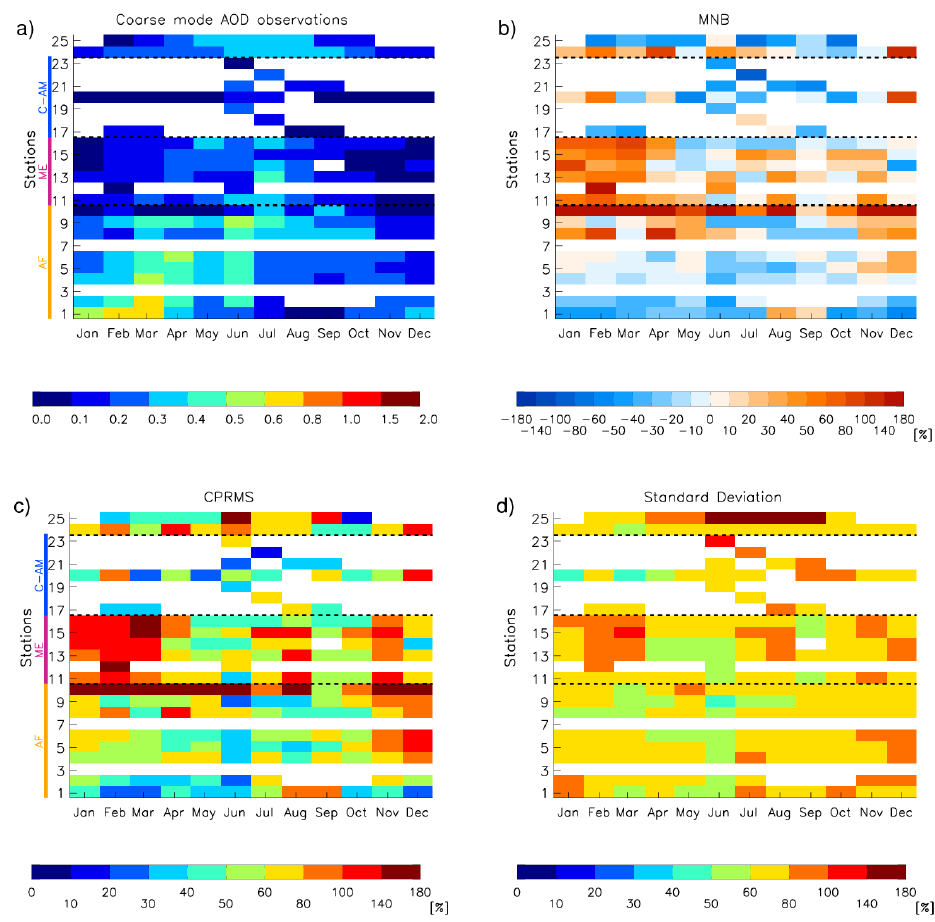
Fig. 11. Same as Fig. 10 but for coarse mode AOD. Same stations as the ones used for total AOD and illustrated in Fig. 8 are consid- ered. Stations Bandoukoui (3) and Bidi Bahn (7) do not have coarse mode AOD for the selected period. For the individual figure of each model presenting the simulated values and their differences (in %) with respect to observations see Figs. S10 and S11, respectively, in the